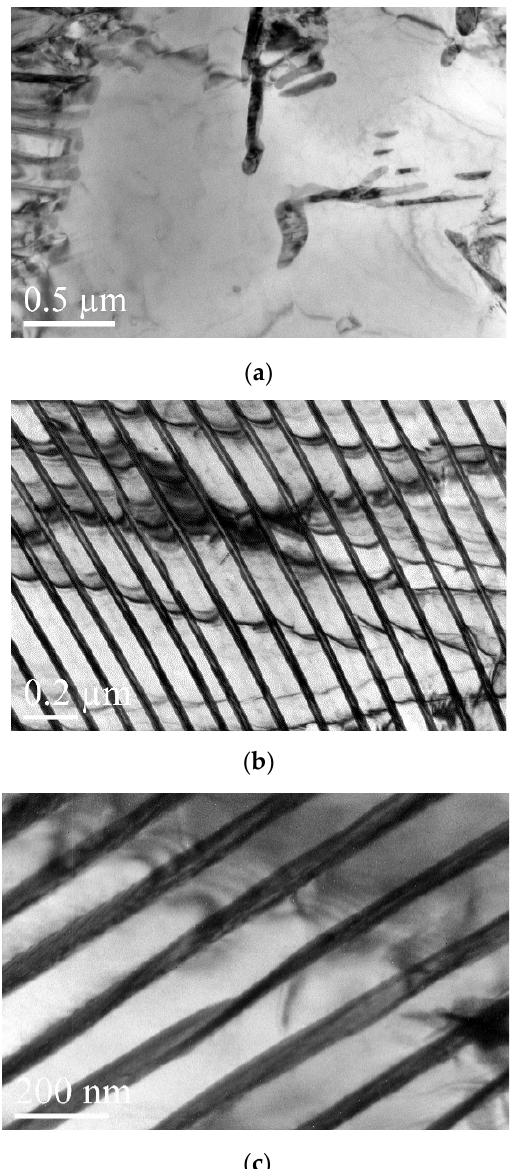
Figure 10. TEM micrographs for J12 that show ( a ) the pro-eutectoid ferrite and pearlite and ( b , c ) pearlite.